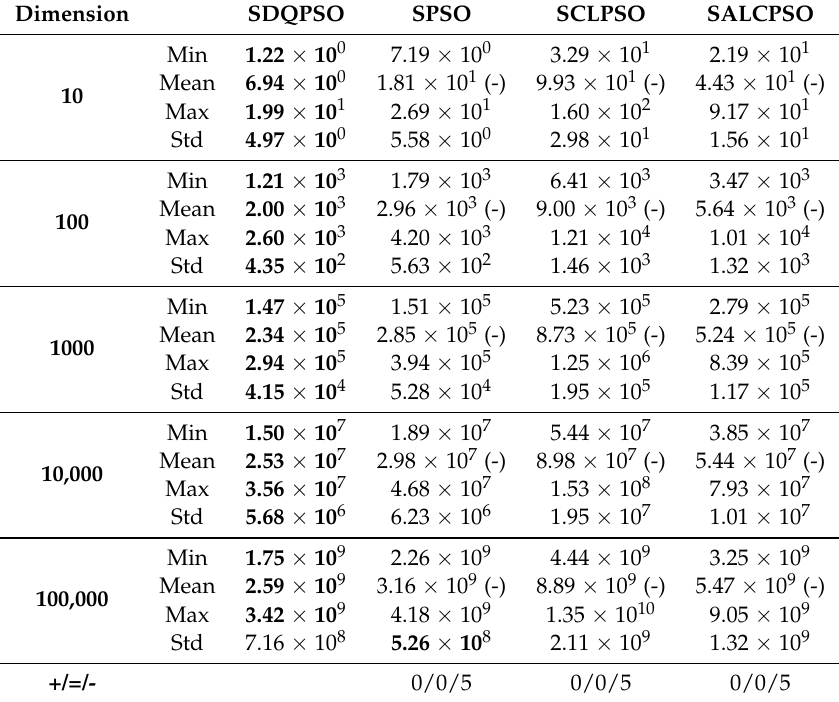
Table 4. Optimization performance under different function